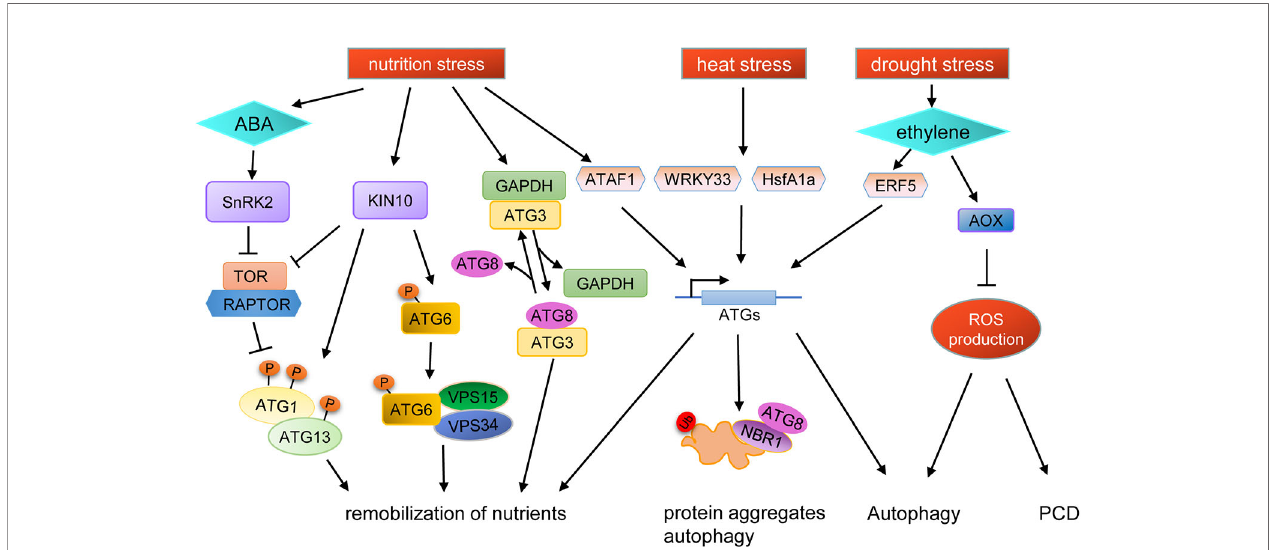
FIGURE 2 | Schematic diagram of autophagy regulation under various stresses. KIN10, a catalytic subunit of SnRK1, is activated by stresses to phosphorylate TOR-interacting proteins, in turn inhibiting TOR kinase activity and activating ATG1. Additionally, active KIN10 can phosphorylate ATG6 and activate the PI3K complex to induce autophagy by an ATG1 kinase independent pathway. Under nutrient starvation stress, SnRK2 is activated by ABA to inhibit the activity of the TOR complex, and the expression of ATG genes are induced by the transcription factor ATAF1, resulting in the promotion of autophagy. Nutrient starvation stress can also cause the dissociation of GAPDH and ATG3, thus promoting the binding of ATG8 and ATG3. The expression of ATG genes are induced by WRKY33 and HsfA1a under heat stress to promote the degradation of protein aggregates through autophagy. Autophagy can also be induced by drought stress in an ethylene- dependent manner. Moreover, autophagy is also regulated by ROS levels during drought stress, in which AOX plays an important